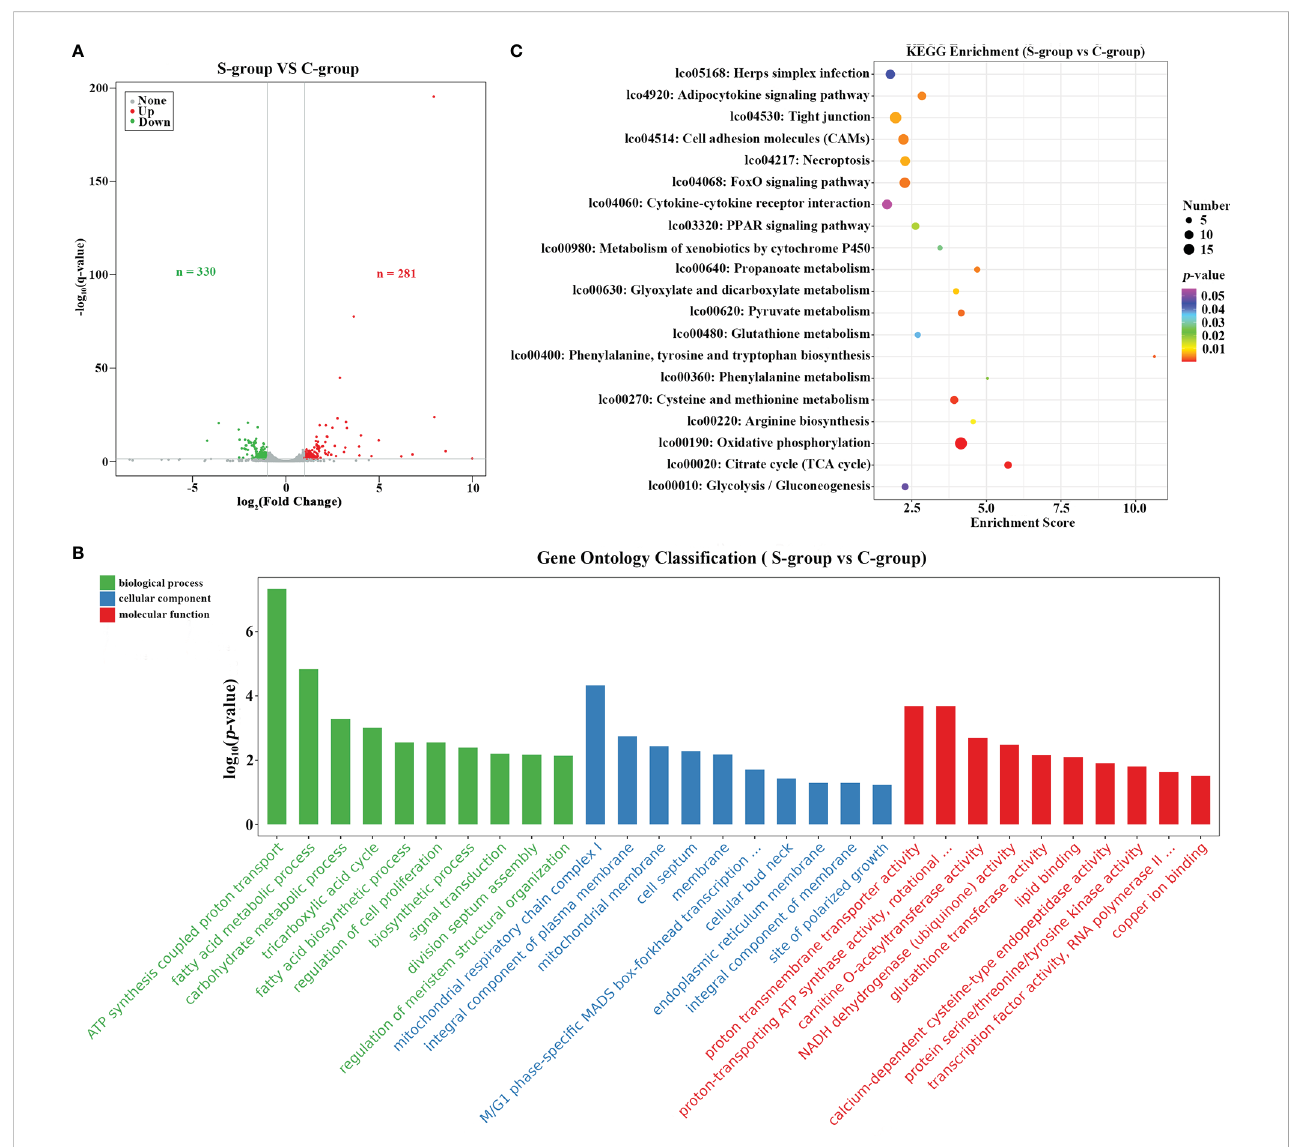
FIGURE 3 Functional enrichment analysis of DEGs. (A) Volcano plot showing the DEGs between different salinity treatments; (B) KEGG pathway enrichment analysis of the up- and down-regulated DEGs; (C) GO enrichment analysis of up- and down-regulated